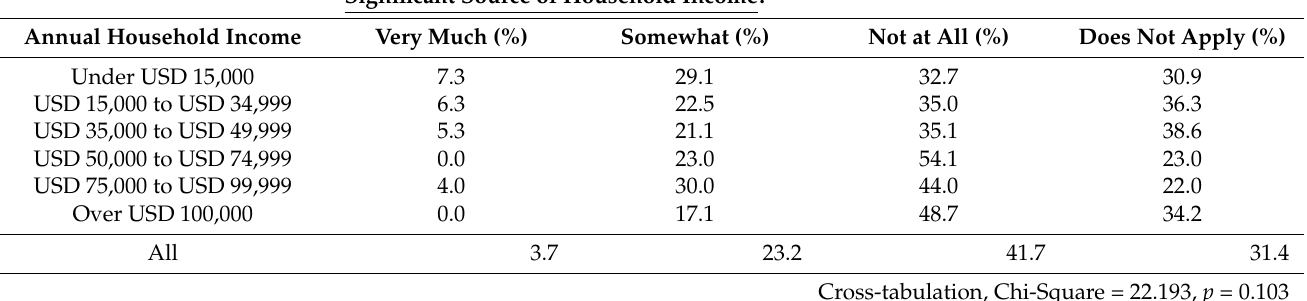
Cross-tabulation, Chi-Square = 22.193, p = 0.103